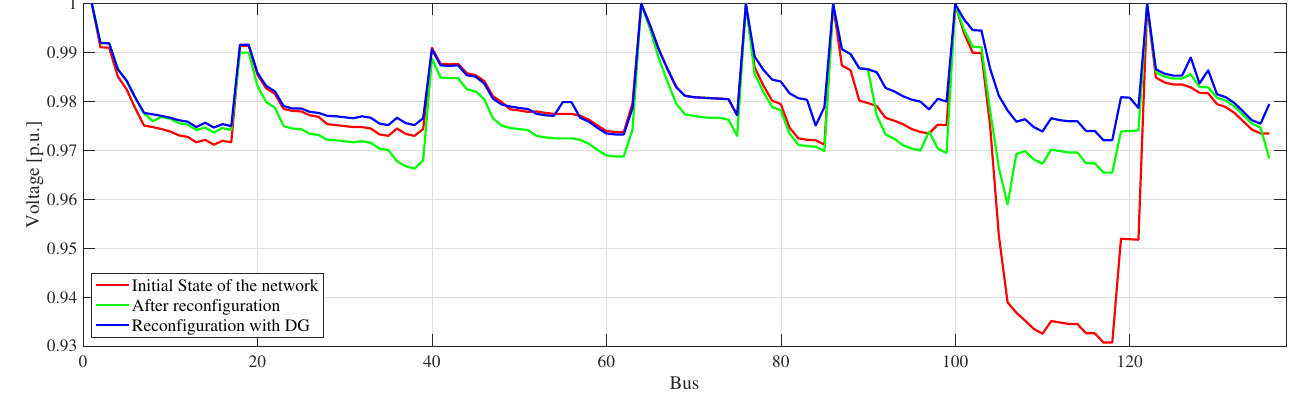
Figure 7. Voltage profile of the 136-bus test